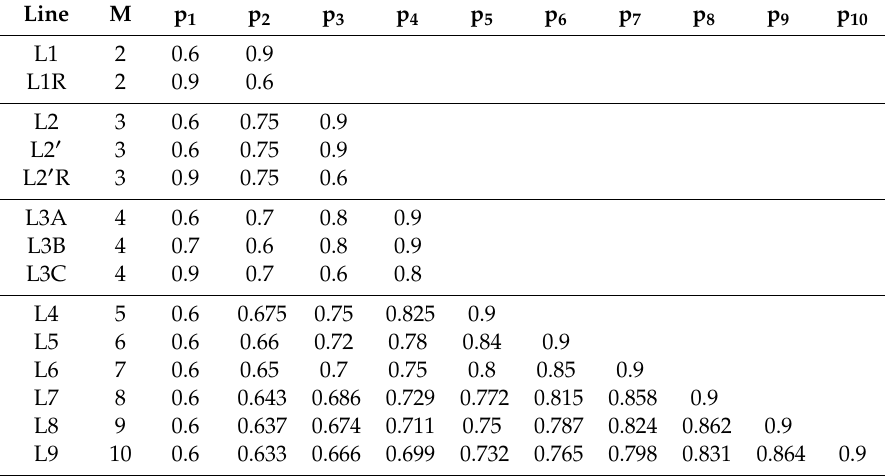
Table 1. List of considered serial Bernoulli production lines with probabilities of the state {up} (authors’